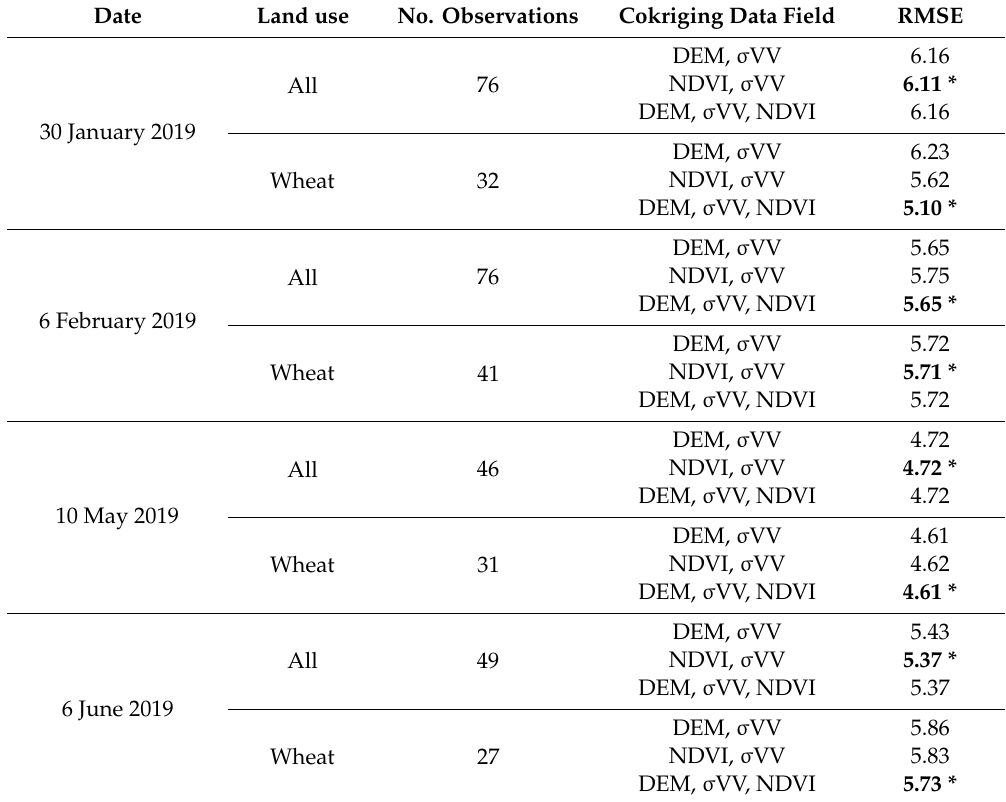
Figure 11. All land uses: Ordinary cokriging soil moisture— ( a ) January 2019, ( b ) February 2019, ( c ) May 2019, and ( d ) June 2019, respectively.